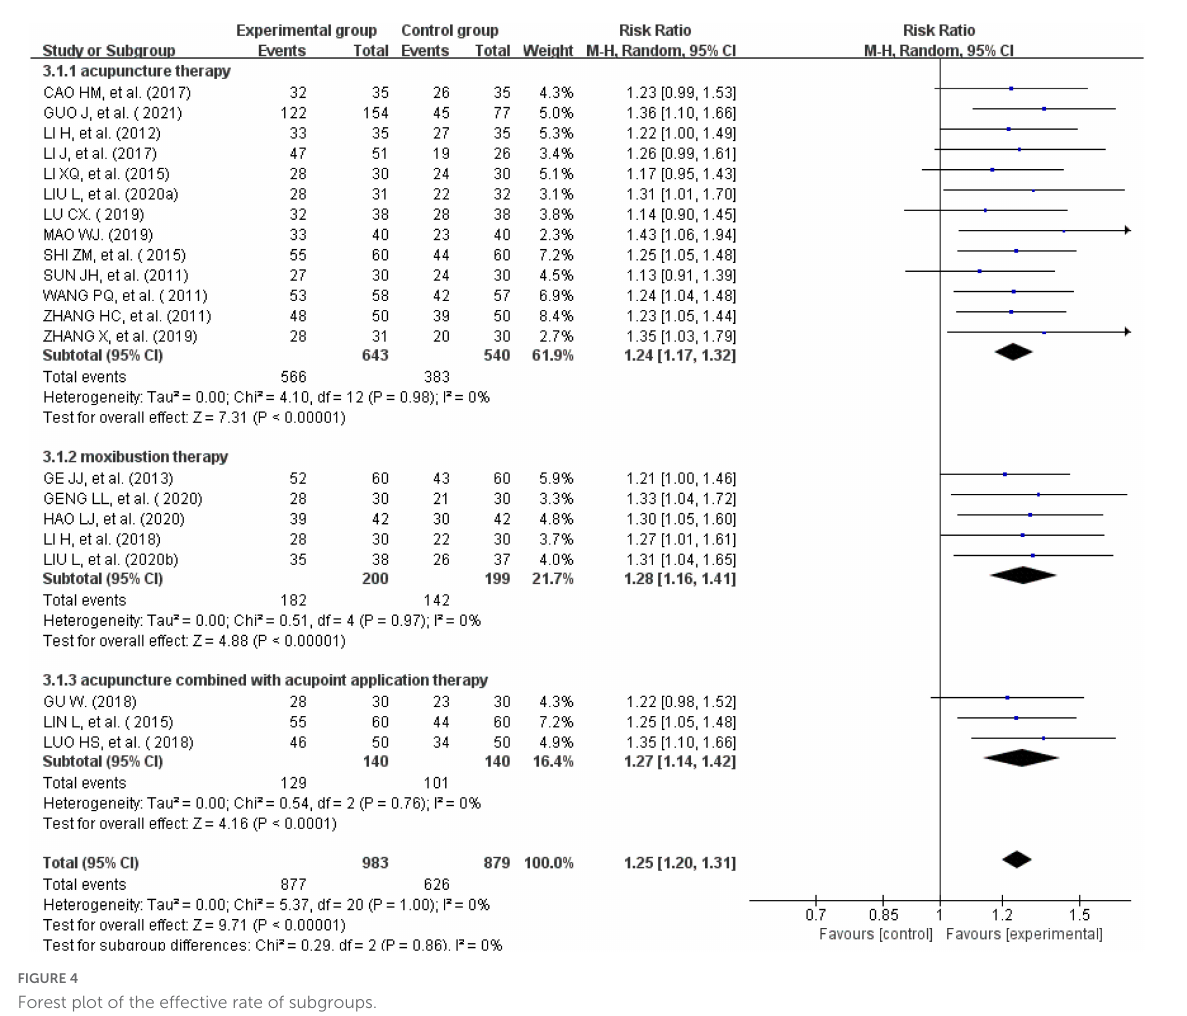
FIGURE4 Forest plot of the effective rate of